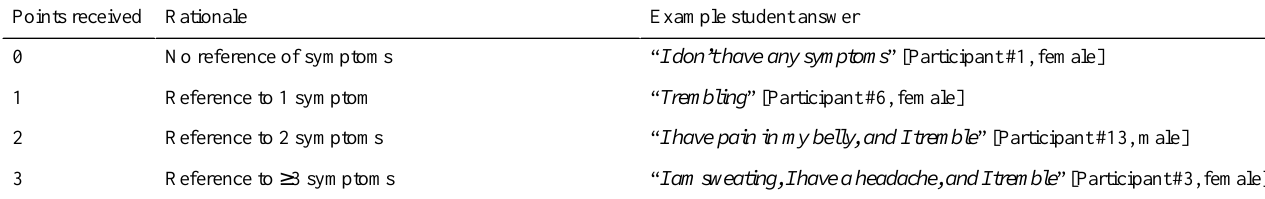
Table 2. Coding sheet for an open-ended question on the identification of somatic symptoms when stressed.